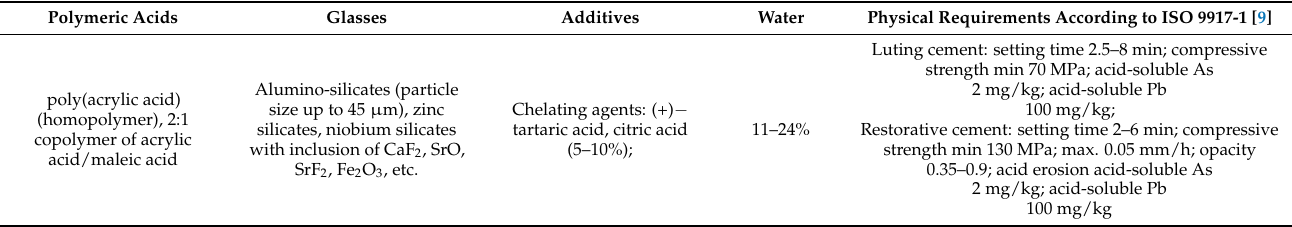
Table 1. Most encountered characteristics of glass ionomer